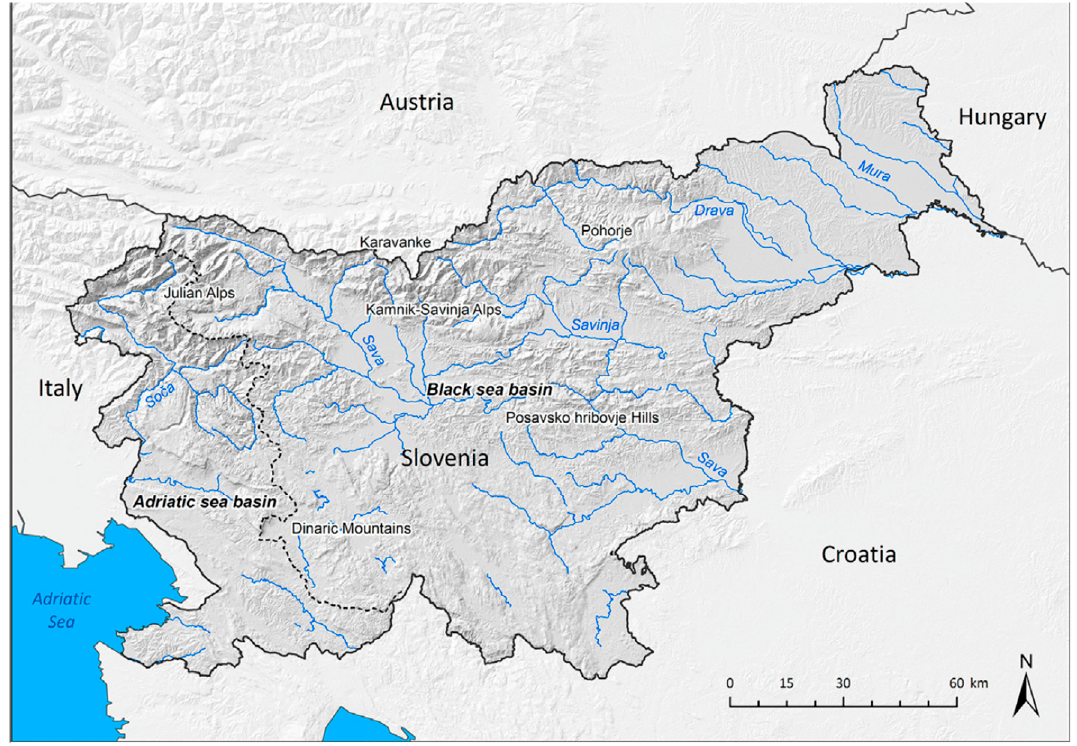
Figure 1. Map of Slovenia [28].